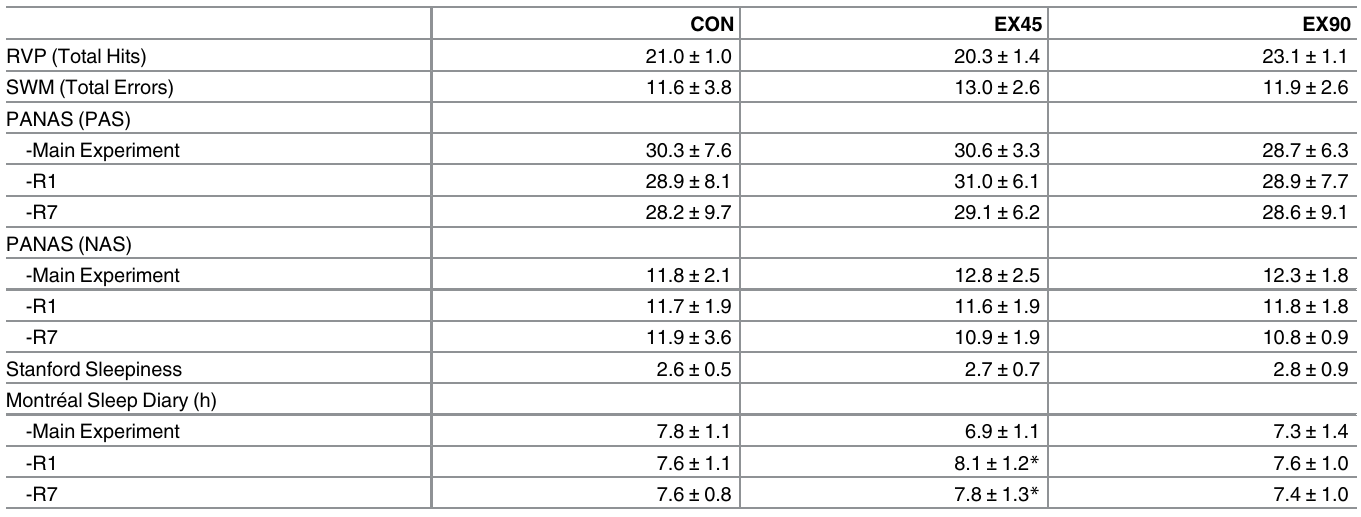
Table 2. Subject Data.